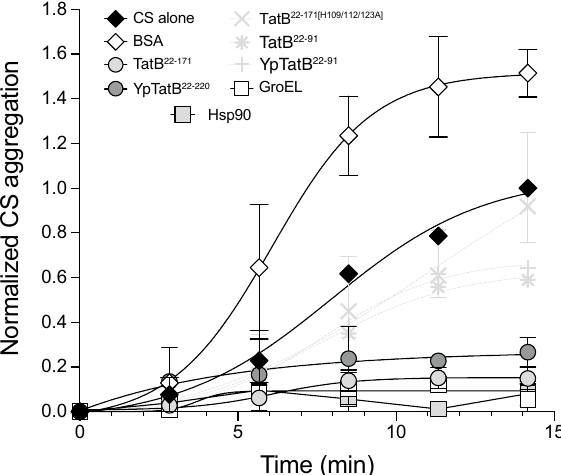
Figure 4. Membrane-extrinsic domain of TatB suppresses thermal aggregation of CS. CS was diluted to a final concentration of 0.15 μM into prewarmed 40 mM HEPES–KOH, pH 7.5, at 43 °C in the absence (CS alone) or presence of 0.15 μM of the following proteins: TatB 22–171 , TatB 22–91 , TatB 22–171[H109/112/123A] , YpTatB 22–220 , YpTatB 22–91 , E. coli GroEL or yeast Hsp90 as indicated. To exclude unspecific protein effects, control experiments in the presence of 0.15 μM bovine serum albumin (BSA) were conducted. Light scattering measurements were performed by measuring absorbance at 500 nm. Data are the average of biological replicates and the error bars represent the standard